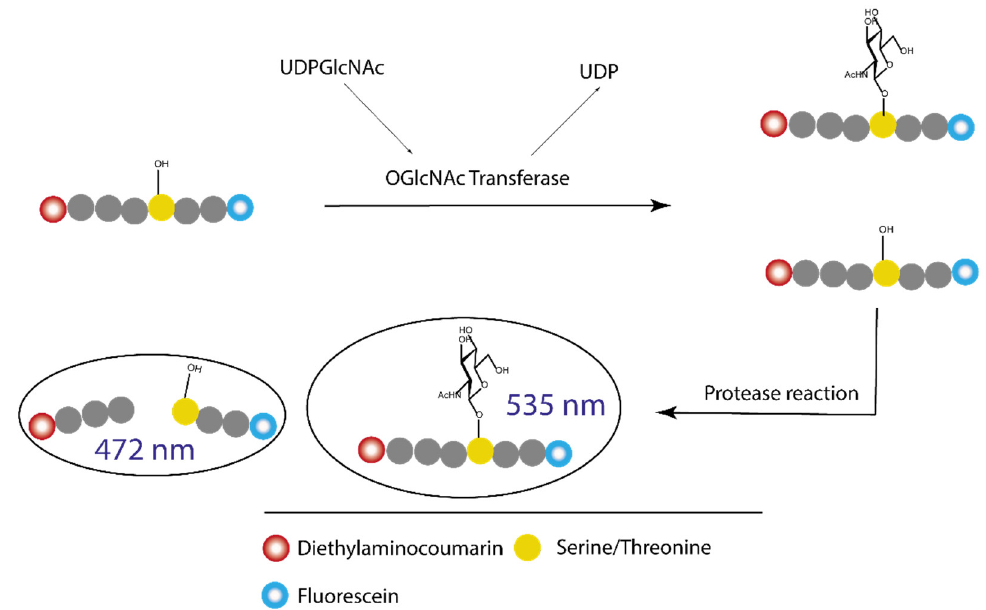
Figure 7. Schematic representation of the fluorescence resonance energy transfer (FRET) assay developed by the Walker group [29]. The GlcNAc acceptor is loaded with two fluorescent probes, diethylaminocoumarin and fluorescein. After the OGT reaction, a portion of the peptide is OGlcNAcylated. The mixture of GlcNAcylated and non-GlcNAcylated peptides is then mixed with a protease that cleaves only the free peptide, preventing FRET.